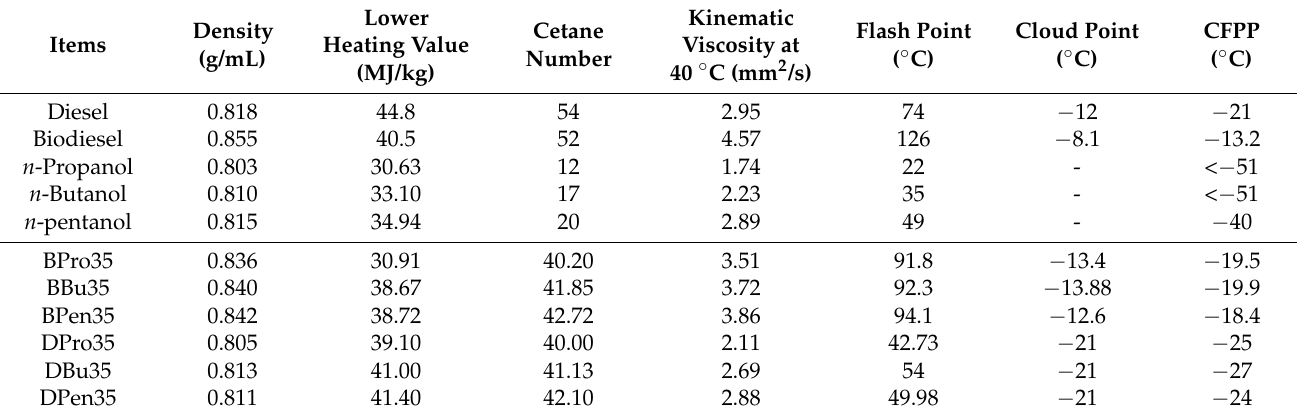
Table 2. Test fuels